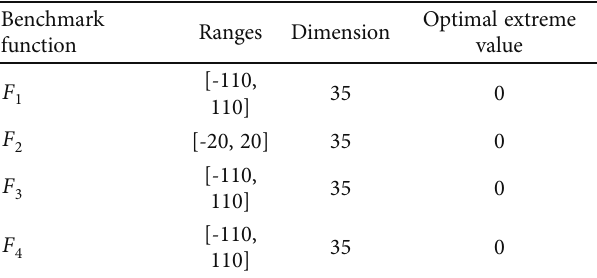
Table 2: Eight benchmark function parameter